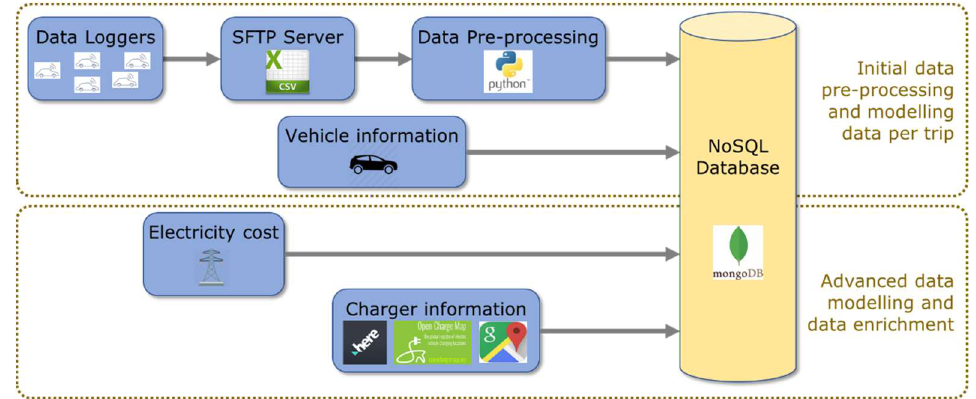
Figure 2. V2G data management platform.